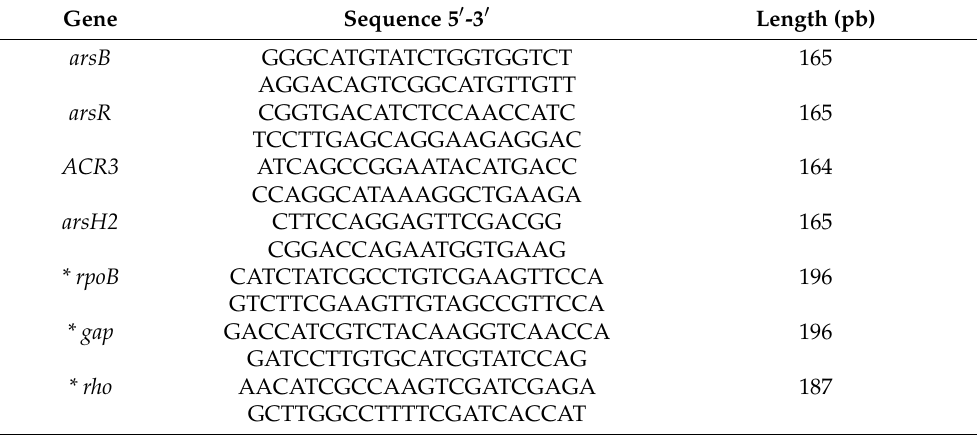
Table 1. Set of primers used in this study for the relative expression assay of genes involved in arsenic resistance in Brevundimonas sp. B10. * Housekeeping